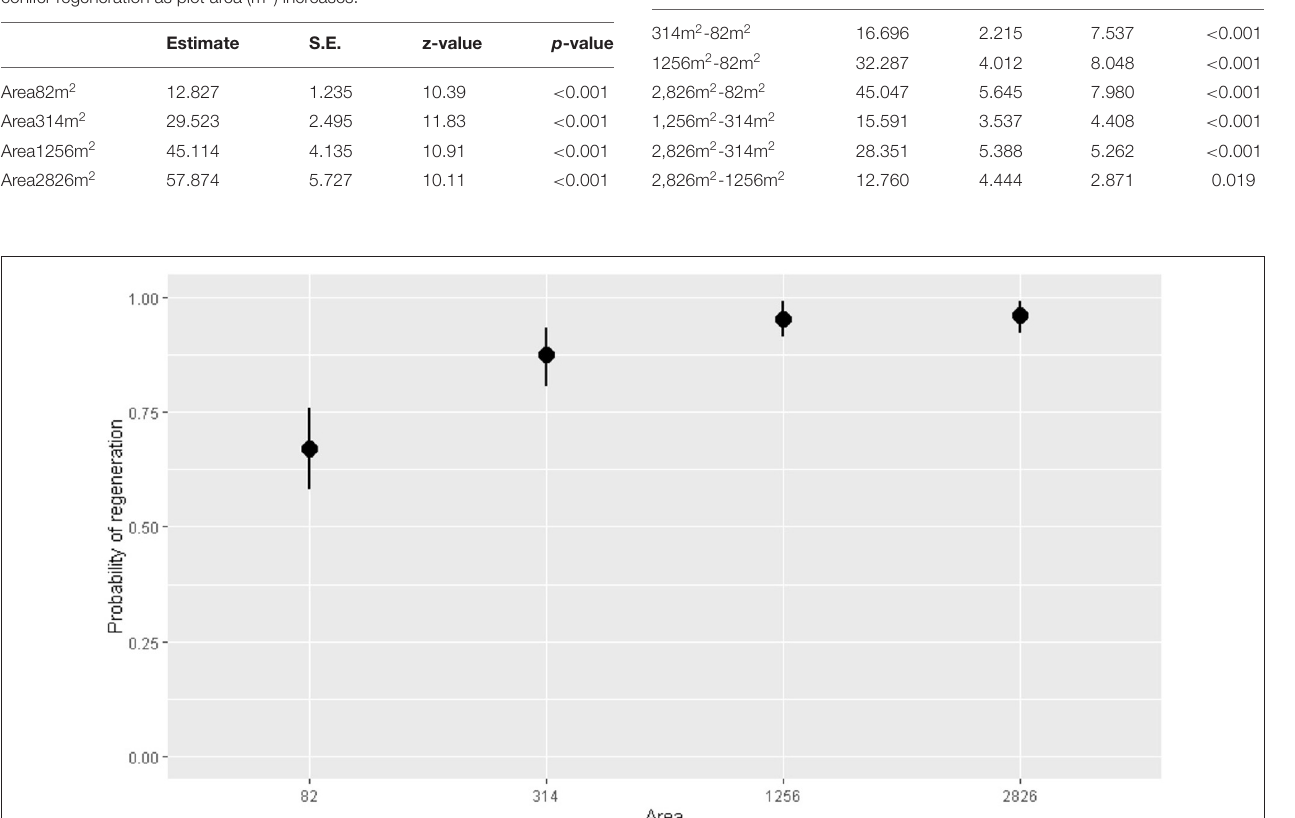
TABLE 2 | Post-hoc Tukey pairwise comparisons between combinations of plot sizes.